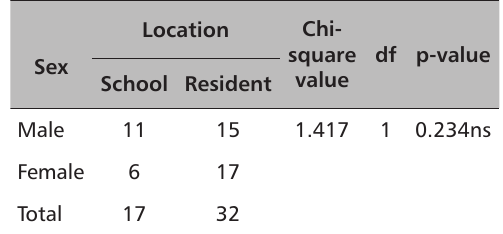
TABLE 2. The effect of location on sex distribution of M.